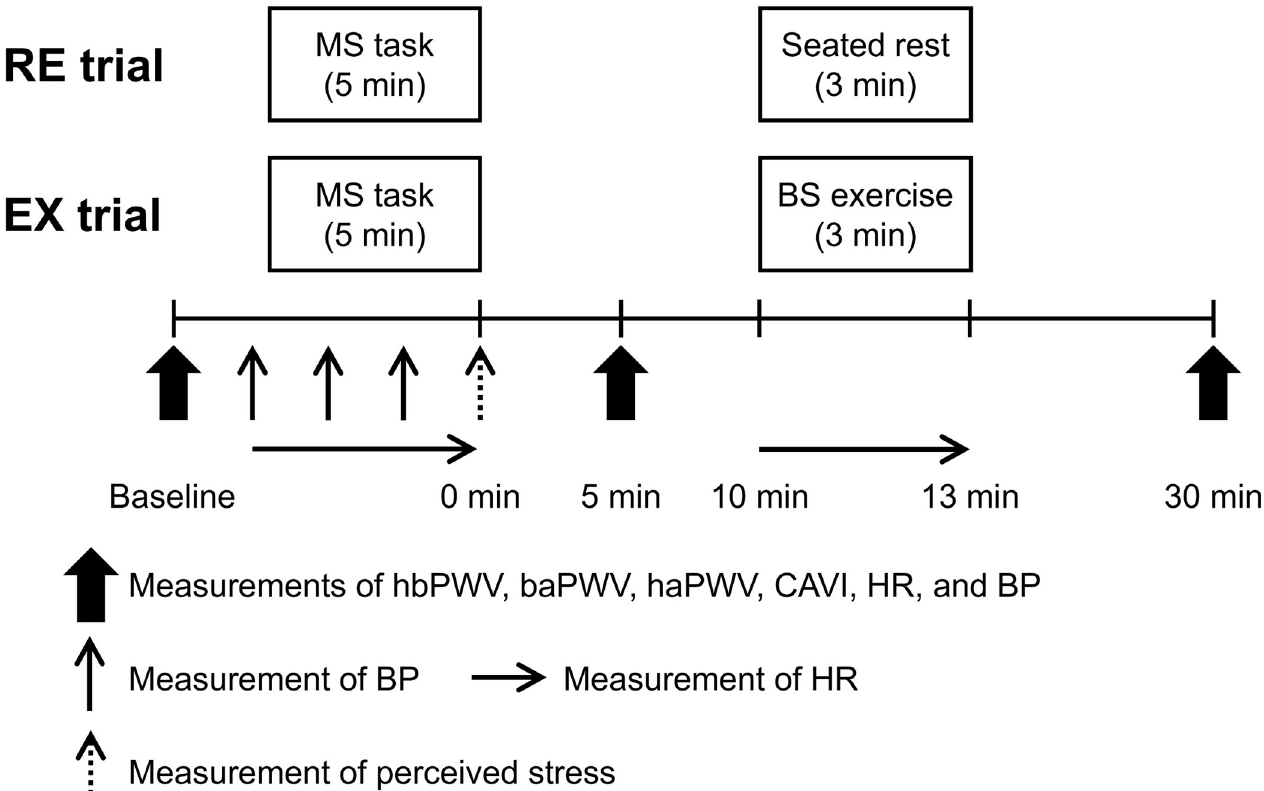
Fig 1. Experimental protocol. RE, rest; EX, exercise; MS, mental stress; BS, bench step; hbPWV, heart-brachial pulse wave velocity; baPWV, brachial-ankle pulse wave velocity; haPWV, heart-ankle pulse wave velocity; CAVI, cardio-ankle vascular index; HR, heart rate; BP, blood pressure.